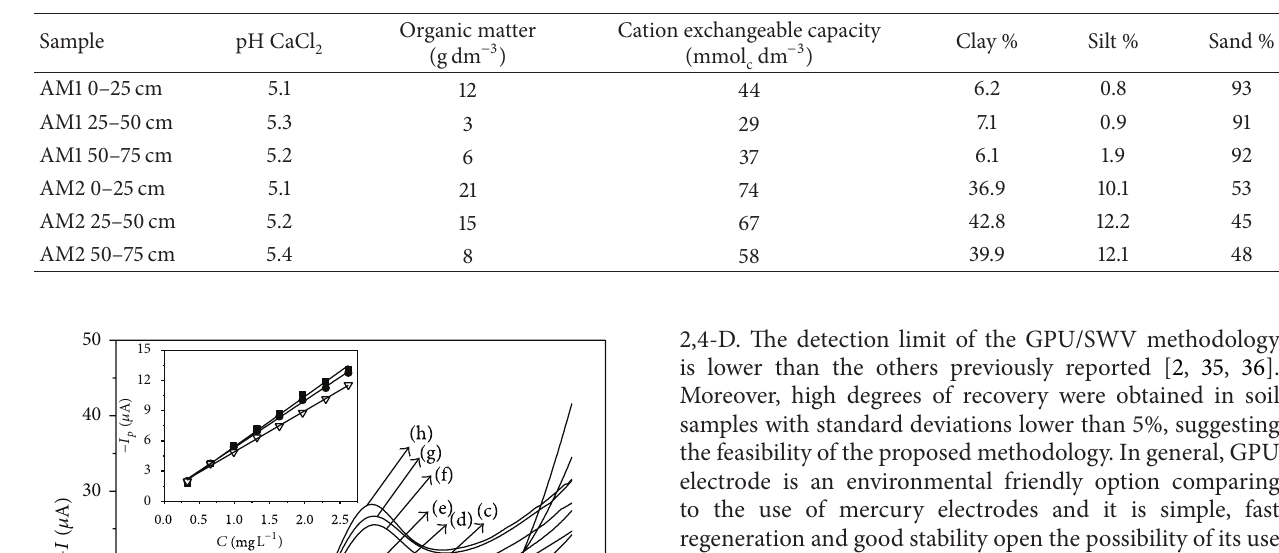
Table 2: Some physicochemical parameters of the soil studied.